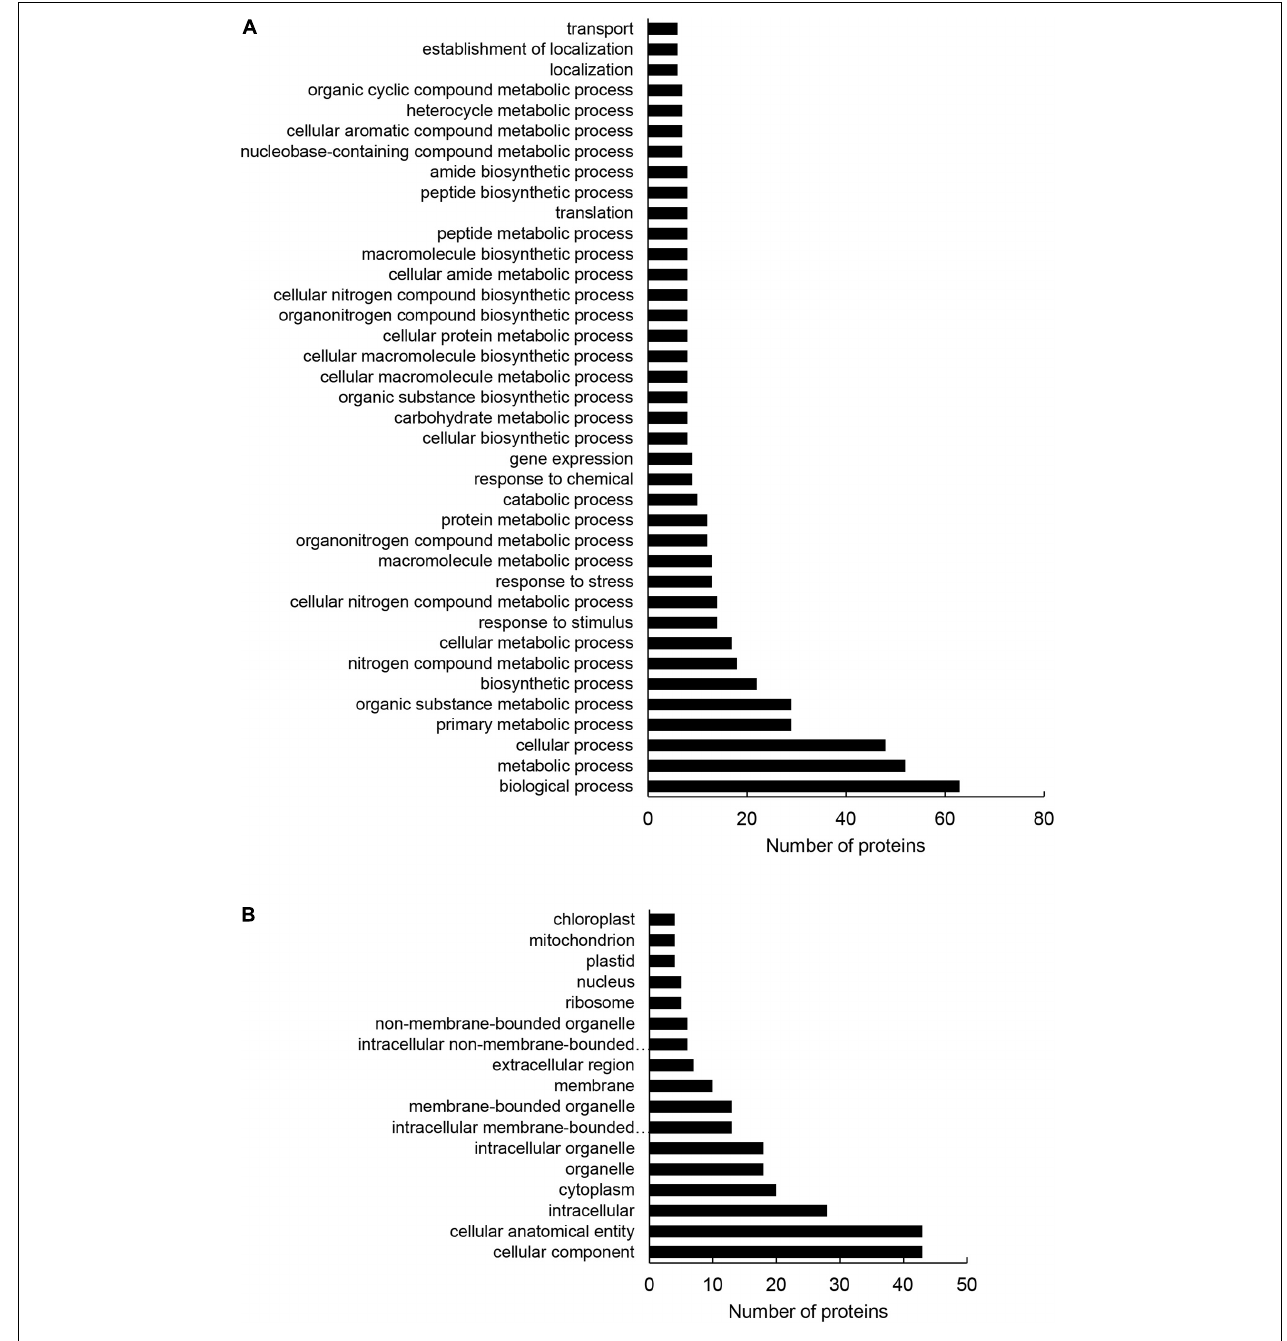
FIGURE 3 | Gene ontology (GO) annotation analysis of root differentially abundant proteins found between HvMPK3 KO lines and wild types. (A,B) GO annotation according to biological process (A) and cell compartment (B) .